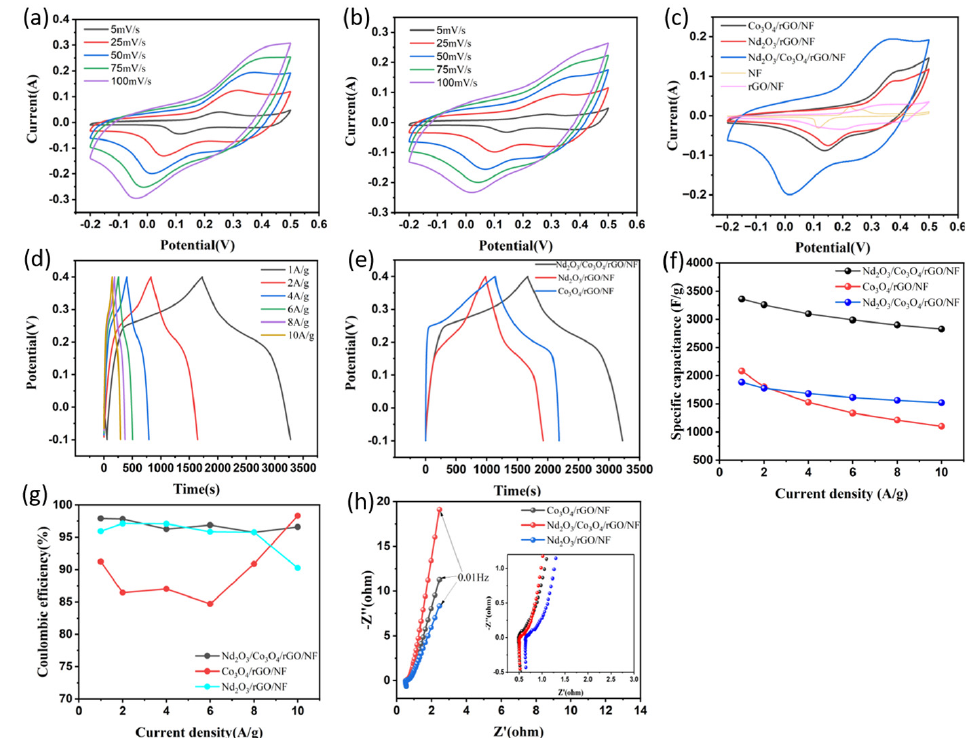
Figure 7. ( a , b ) CV curves of Nd 2 O 3 /Co 3 O 4 /rGO/NF and Nd 2 O 3 /Co 3 O 4 /NF electrodes under different scan rates; ( c ) comparison CV curves of Nd 2 O 3 /Co 3 O 4 /rGO/NF, Nd 2 O 3 /rGO/NF, Co 3 O 4 /rGO/NF, rGO/NF and NF electrodes at 50 mV/s; ( d ) GCD curves of Nd 2 O 3 /Co 3 O4/rGO/NF electrodes at different current densities; ( e ) comparison GCD curves of Nd 2 O 3 /Co 3 O 4 /rGO/NF, Nd 2 O 3 /rGO/NF and Co 3 O 4 /rGO/NF electrodes at 1 A/g; ( f ) specific capacitances of Nd 2 O 3 /Co 3 O 4 /rGO/NF, Nd 2 O 3 /rGO/NF and Co 3 O 4 /rGO/NF electrodes at different current densities; ( g ) the Coulombic efficiencies of Nd 2 O 3 /Co 3 O 4 /rGO/NF, Nd 2 O 3 /rGO/NF and Co 3 O 4 /rGO/NF at different current densities; ( h ) the Nyquist plots of Nd 2 O 3 /Co 3 O 4 /rGO/NF, Nd 2 O 3 /rGO/NF and Co 3 O 4 /rGO/NF electrodes, the circuit inset is the high-frequency region. All of the electrochemical measurements described above were performed in a 6 mol/L KOH solution.